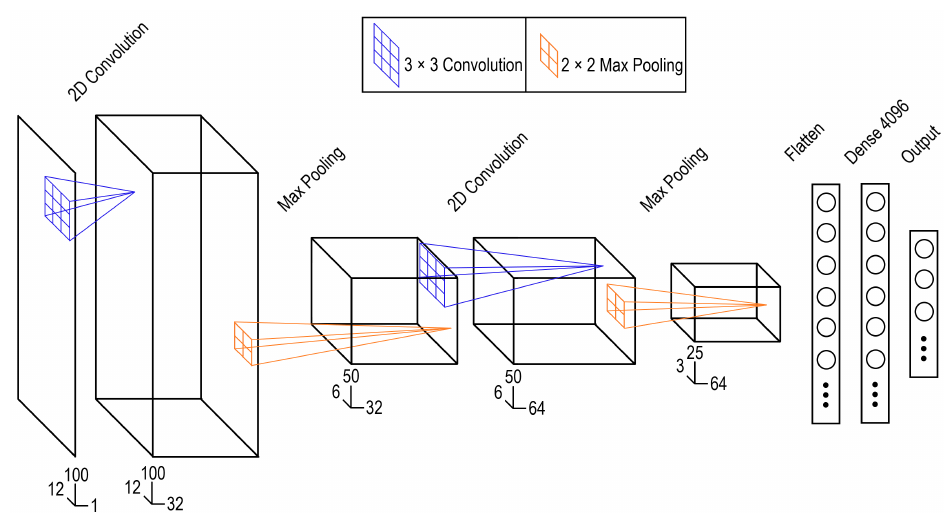
Figure 6. Convolutional neural network architecture showing the convolution (blue) and pooling (orange) operations along with the dimensions of transformed input data .